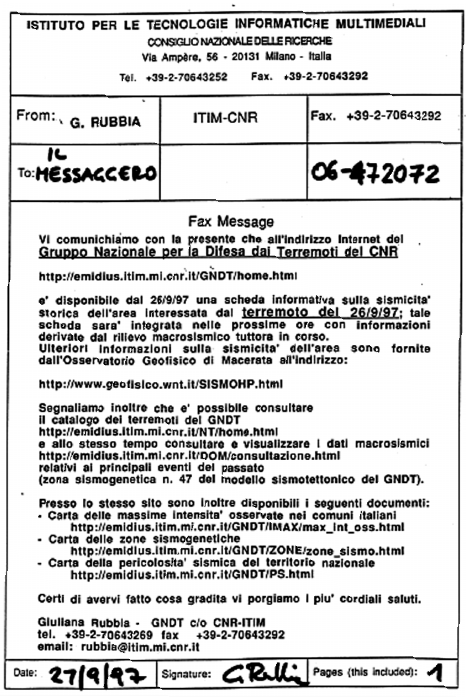
Fig. 1. Fax Message sent on September 27, 1997 by the webmaster of Gruppo Nazionale per la Difesa dai Terremoti to the daily newspaper Il Messaggero. «We announce that on the website of Gruppo Nazionale per la Difesa dai Terremoti of National Research Council http://emidius.itim.mi.cnr.it/ GNDT/home.html, a report is available about the historical seismicity of the area stroke by the earth- quake of 26/9/97; the report will be updated in the next hours with information provided by the macro- seismic survey which is still carried on. Further in- formation are provided by Osservatorio Geofisico di Macerata at http://www.geofisico.wnt.it/SISMOHP .html We notify that it is also possible to browse the GNDT earthquake catalogue http://emidius.itim.mi. cnr.it/NT/home.html and at the same time to retrieve and visualize macroseismic data of most significant past event http://emidius.itim.mi.cnr.it/DOM/consul- tazione.html (seismogenic zone no.47 according to seismotectonical model by GNDT). On the same website the following documents are available: Map of Maximum Observed Intensities in the Italian Municipalities, http://emidius.itim.mi.cnr.it/GNDT /IMAX/max_int_oss.html; Map of seismogenic zones http://emidius.itim.mi.cnr.it/GNDT/ZONE/ zone_sismo.html, Map of seismic hazard of the Ital- ian territory http://emidius.itim.mi.cnr.it/PS.html. Best